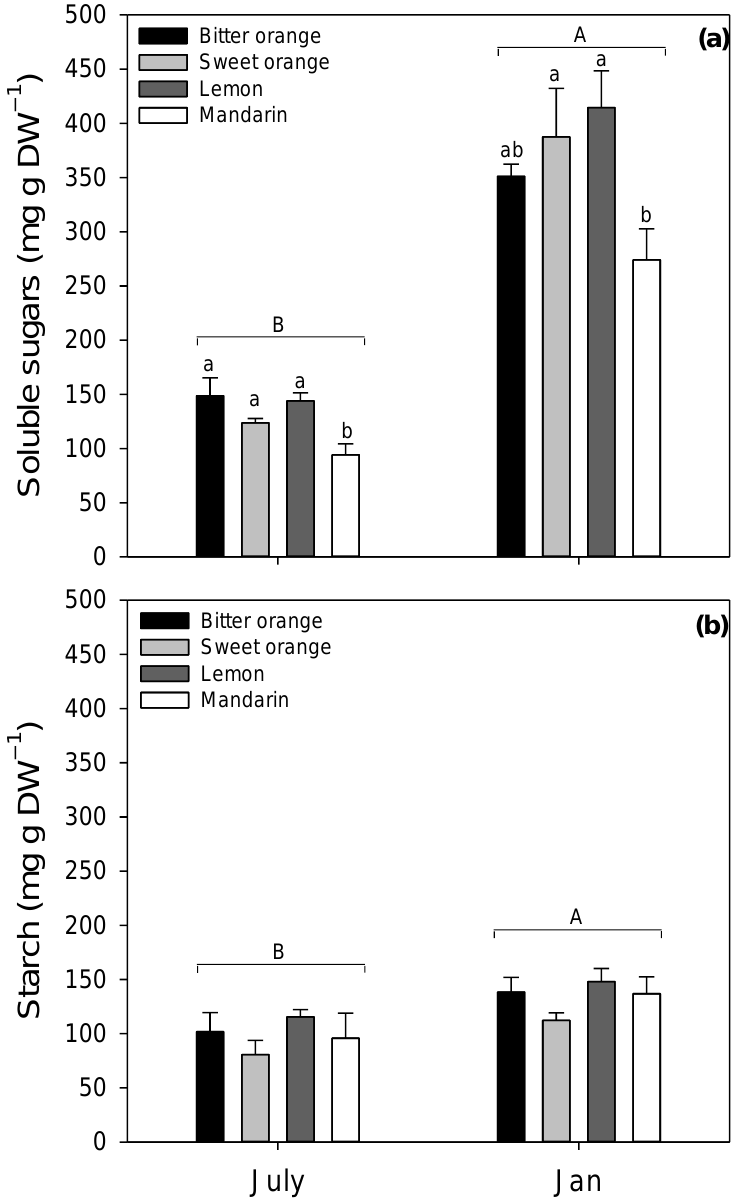
Figure 4. Leaf content of non-structural carbohydrates (mg g DW − 1 ) in Citrus spp. in January and July: ( a ) soluble sugars; ( b ) starch. Data are means ± standard error ( n = 5). Statistics as in Figure 1. Different lowercase ( a ) and uppercase ( a , b ) letters indicate significant differences among species and months, respectively ( p ≤ 0.05, Fisher’s LSD). Non-structural carbohydrates showed a significant variability among species and months, as evidenced by two-way ANOVA analysis of variance (Table 3). The content of leaf carbohydrates was higher in January compared to July (soluble sugars +179.5%; starch +36%, on average). The interspecific mean content of soluble sugars (Figure 4a) was 127.61